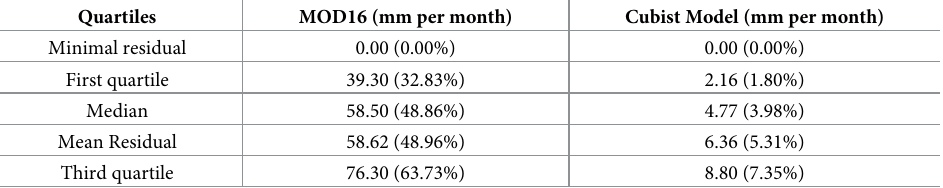
Table 3. Residuals of MOD16 PET and the values predicted by Cubist model in relation to the observed data (weather